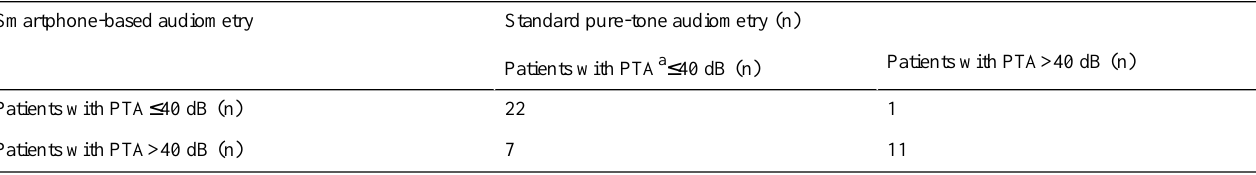
Table 5. Accuracy of smartphone-based audiometry as a screening test compared to the standard pure-tone audiometry (N=41).